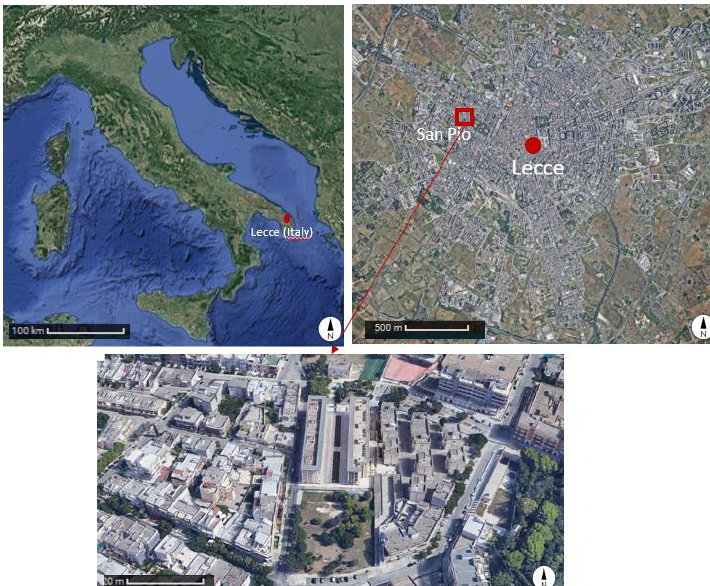
Figure 1. Top: position of the city of Lecce in southern Italy with a focus on the study area (referred to as San Pio hereinafter). Bottom: 3D view of San Pio neighbourhood (modified from Google Earth).